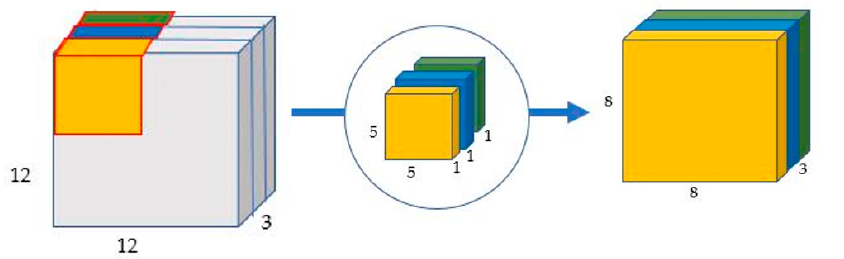
Figure 6. Depth-wise convolution uses three kernels to produce an 8 × 8 × 1 image from a 12 × 12 × 1 image.